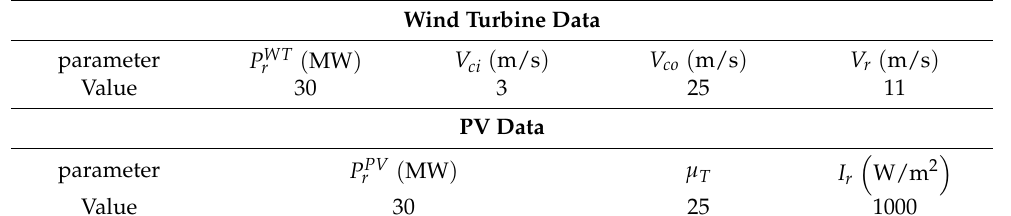
Table 4. Utility sale and purchase rate for 24 h.